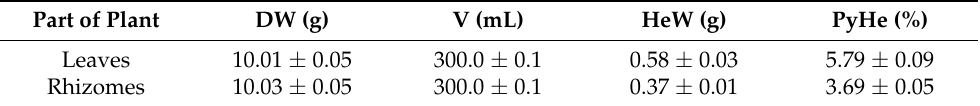
Table 1. Dry weight of A. quercifolia and added volume of the solvent. Part of Plant